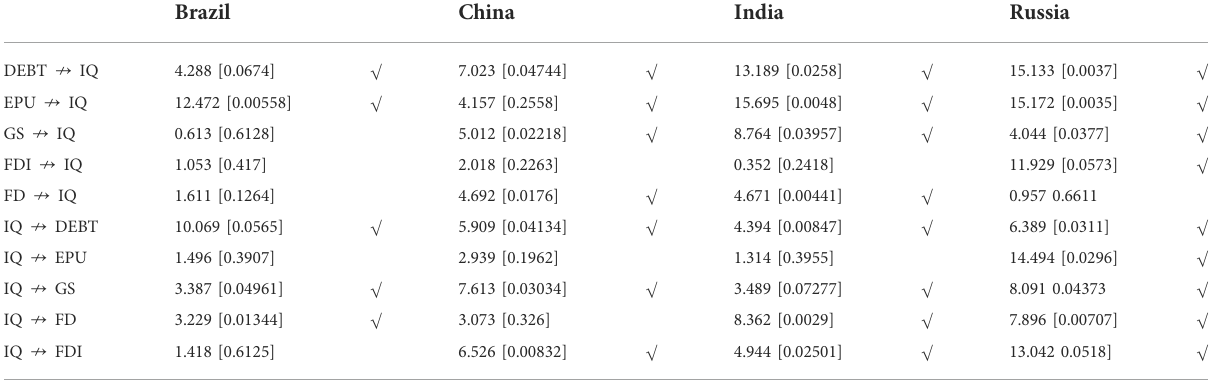
TABLE 8 Toda – Yamamoto Fourier causality